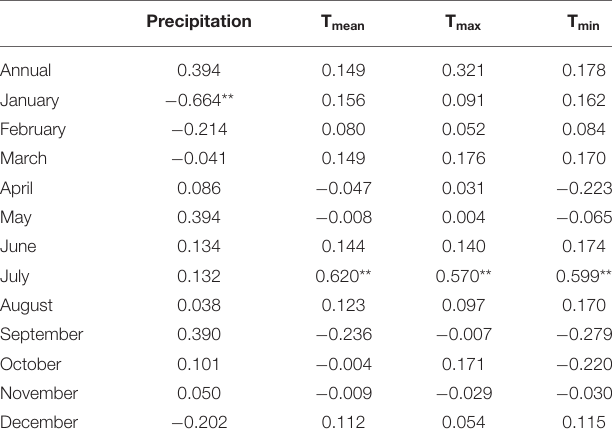
TABLE 1 | Correlation coefficients between precipitation, mean temperature